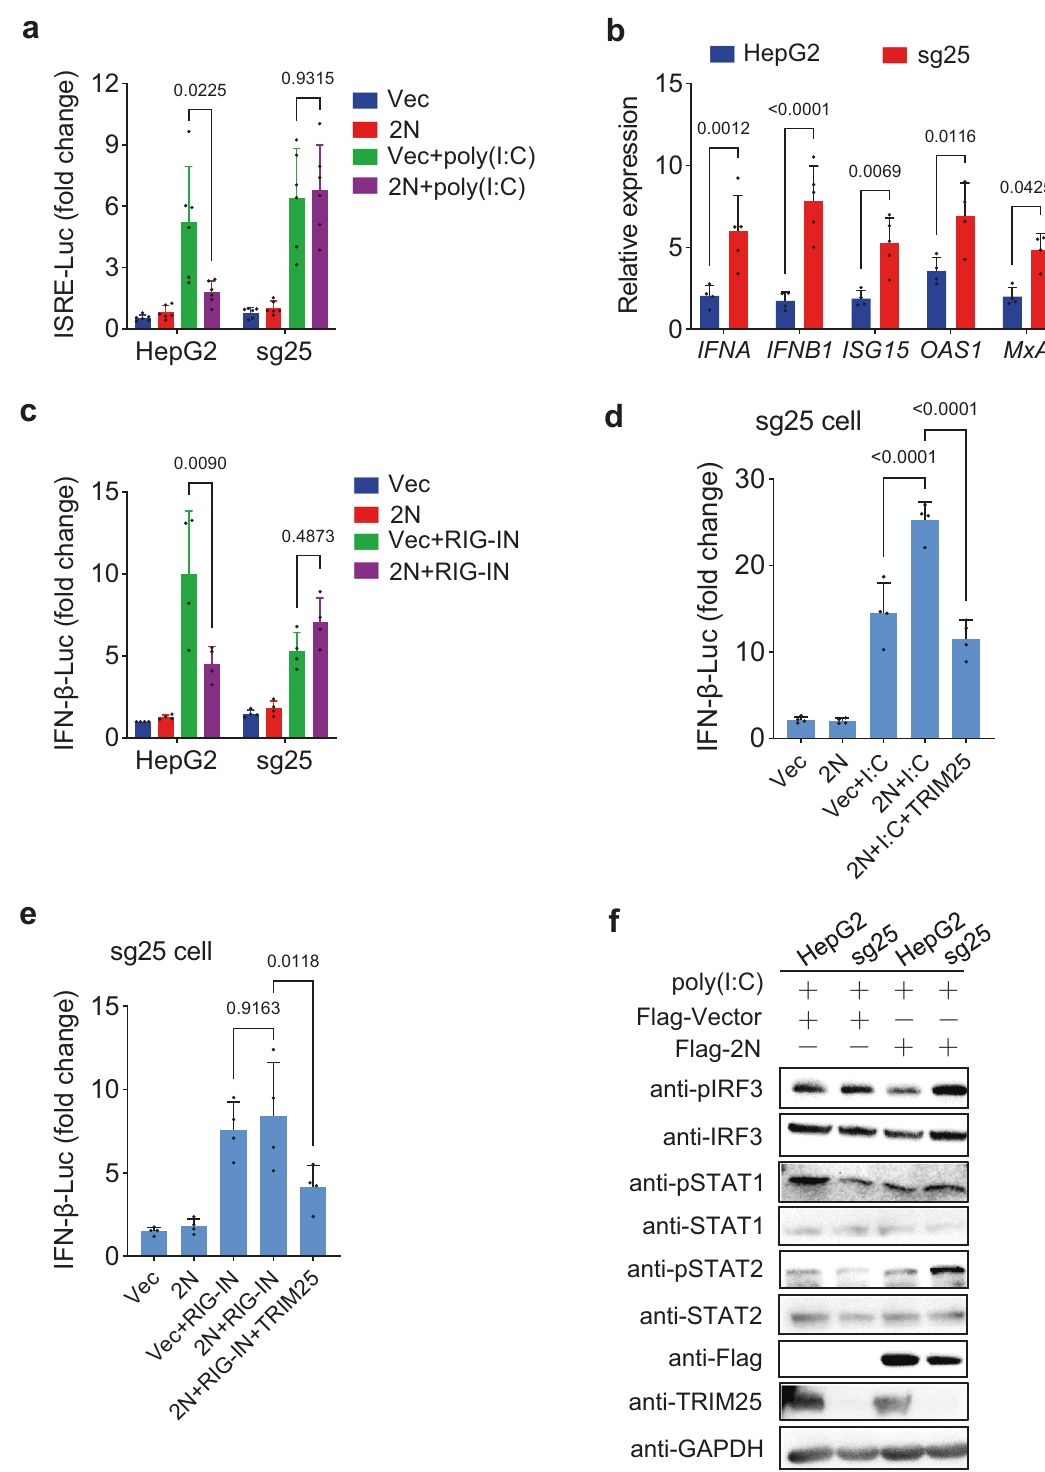
Fig. 4 Low-dose 2N protein inhibits IFN-I production through TRIM25. a TRIM25 knockout (sg25) and WT HepG2 cells in 24-well plate were transfected with an ISRE reporter and 0.25 μ g 2N plasmids, together with or without poly(I:C). At 24 hpt, cells were harvested and luciferase activity was measured. b sg25 and HepG2 cells in 24-well plate were transfected with 0.25 μ g 2N and poly(I:C). At 24 hpt, the mRNA levels of IFNA , IFNB1 , ISG15 , OAS1 , and MxA were determined using qPCR. c sg25 and HepG2 cells were transfected with the plasmids as indicated. At 24 hpt, the luciferase activity were measured. d , e sg25 cells were co-transfected with the plasmids as indicated. At 24 hpt, the luciferase activity was measured. f sg25 and HepG2 cells were transfected with 0.25 μ g Flag-2N or empty vector together with poly(I:C). At 24 hpt, the phosphorylation levels of IRF3, STAT, or STAT2 were detected by western blot. Results shown are the mean ± SD of at least three independent